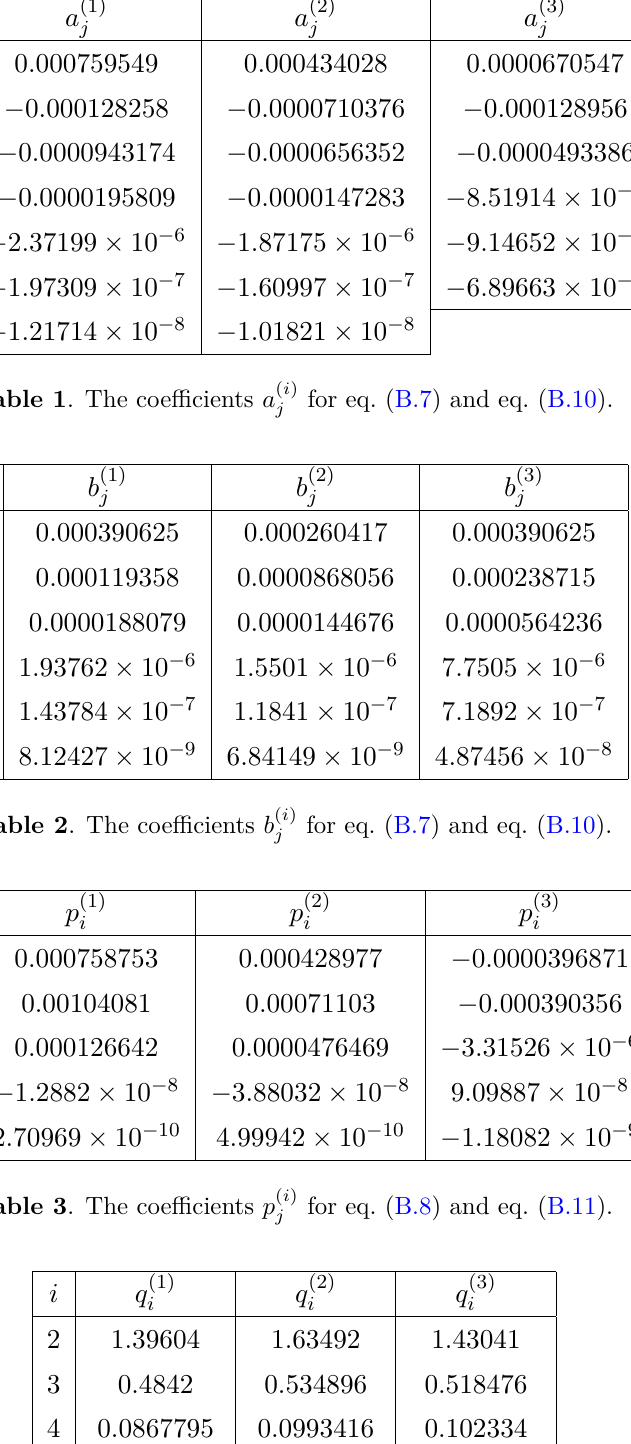
Table 4 . The coefficients q ( i )